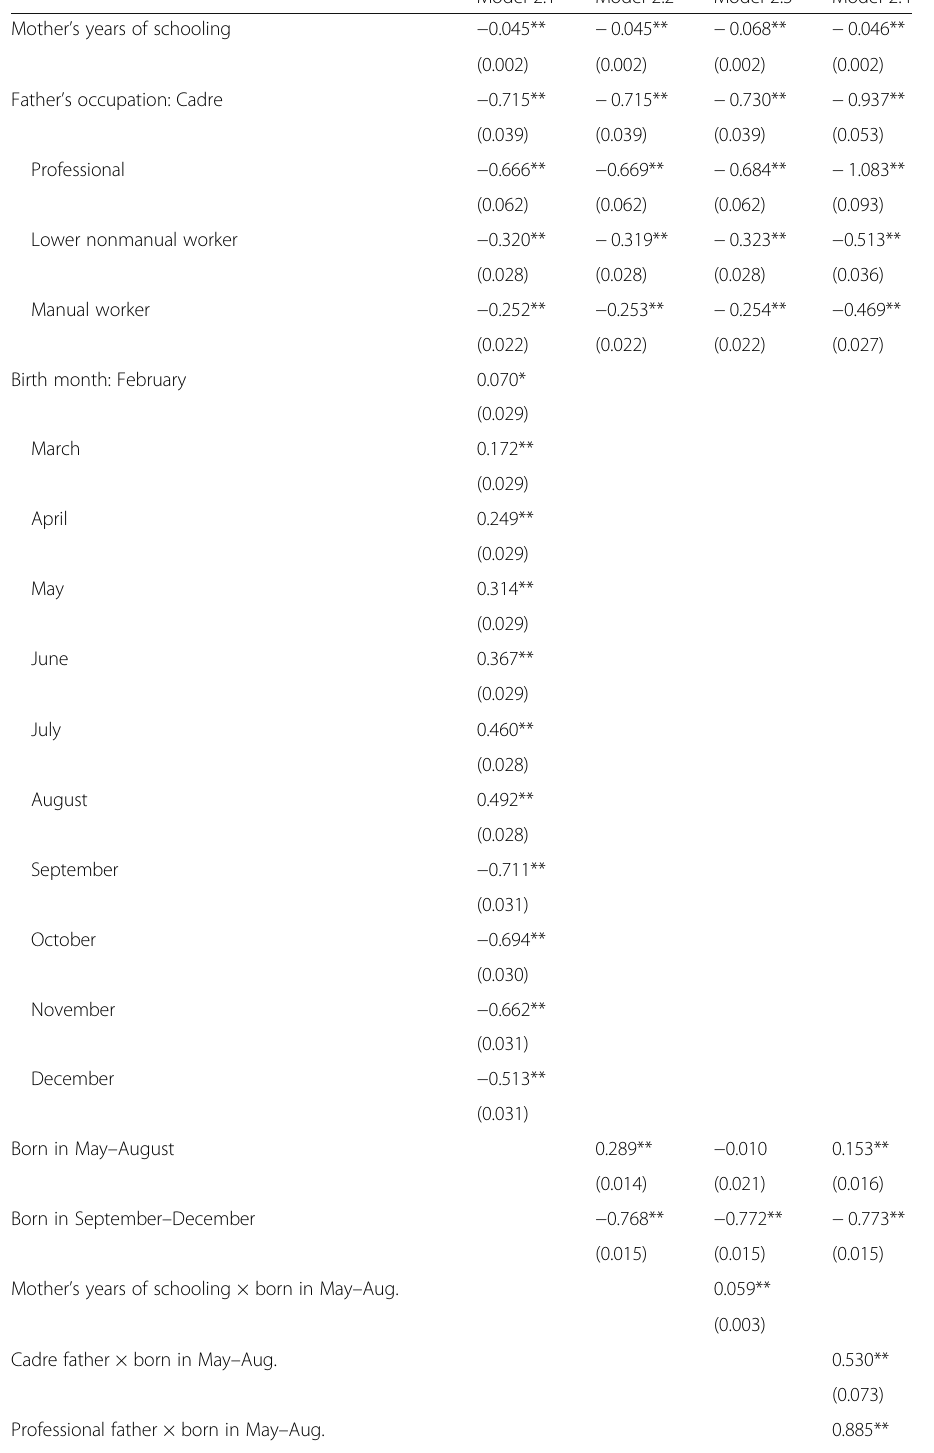
Table 2 The logistic regression of delayed school entry for one year on child ’ s birth